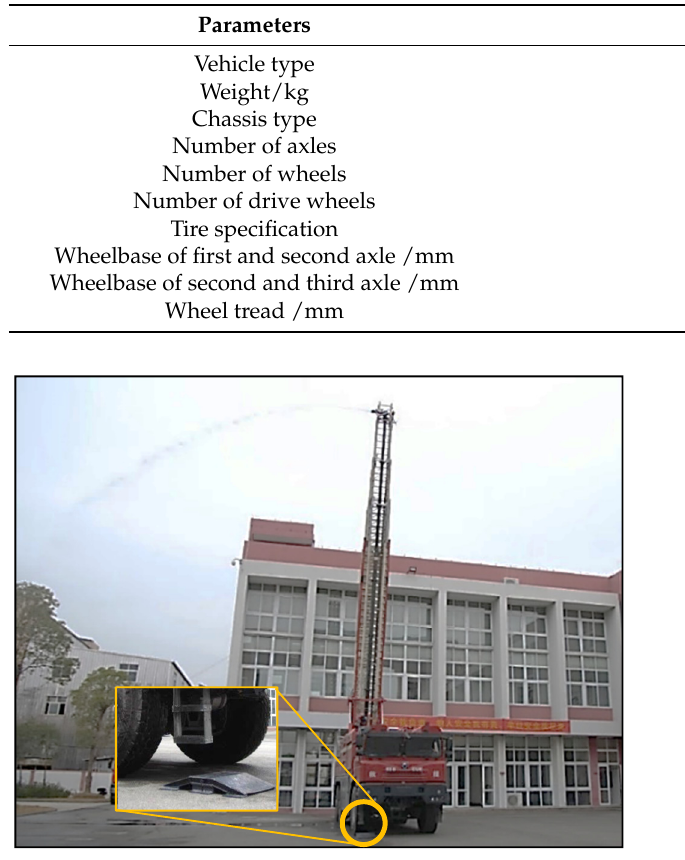
Figure 11. Test vehicle and site.